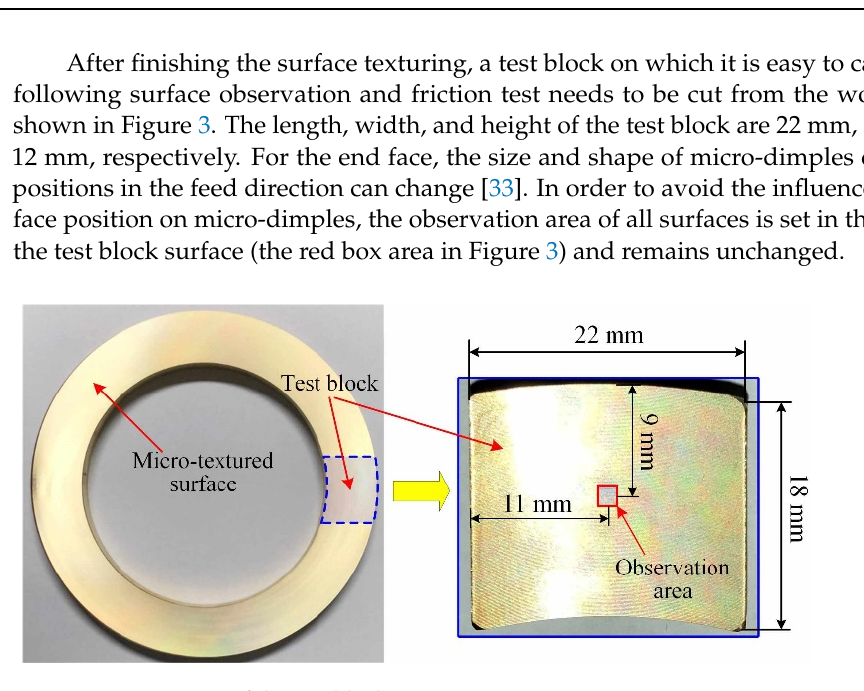
Figure 3. Preparation of the test